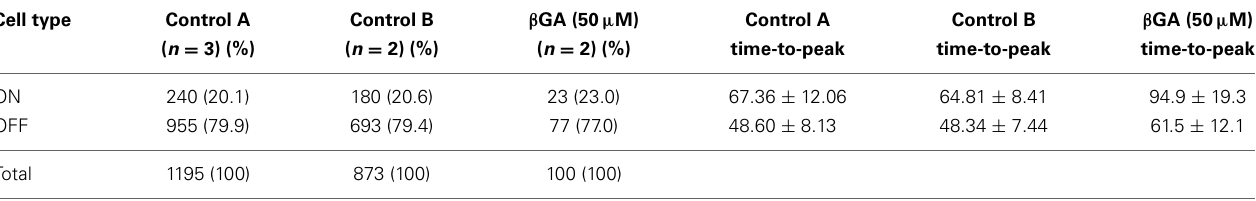
Control A corresponds to three different experiments (including the two in Control B) under normal conditions and represents a total of 1195 GCs. Control B and β -GA corresponds to two experiments under control (n = 873 GCs) and β -GA conditions (50 μ M; n = 100 GCs). Time-to-peak corresponds to the interval between the stimulus presentation and the spike occurrence. The last two columns show the statistics of time-to-peak values (in ms, see Figure 5 ) for each GC